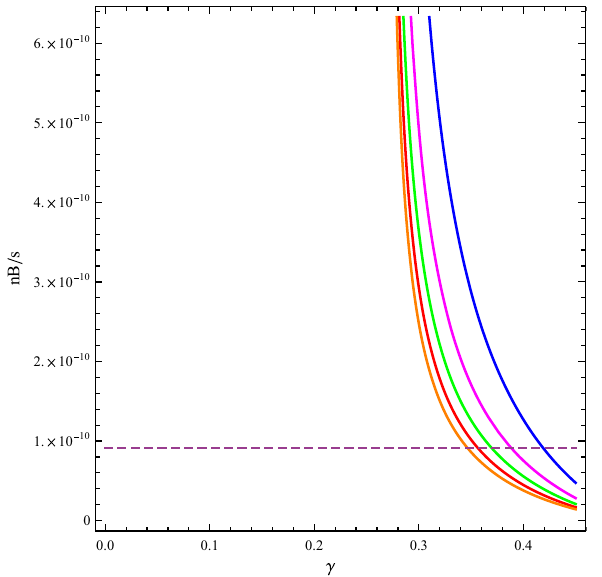
Fig. 4 The baryon to entropy ratio for the model f ( R , T ) = R + λ T + μ T 2 in function of μ . The graphs are plotted for γ = 0 . 28 and for the varying values of λ , λ = 10 2 (blue), λ = 1 . 5 × 10 2 (magenta), λ = 2 × 10 2 (green), λ = 2 . 5 × 10 2 (red), λ = 3 × 10 2 (orange) and the dashed curve represents observational